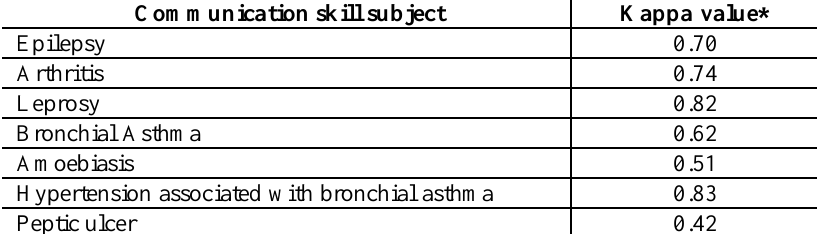
* A kappa value of 0.81-1 indicates very good agreement, a value between 0.61-0.8 indicates substantial agreement and 0.41-0.6 indicates moderate agreement. Values between 0.21-0.4 indicate fair agreement, values less than 0.2 indicates poor